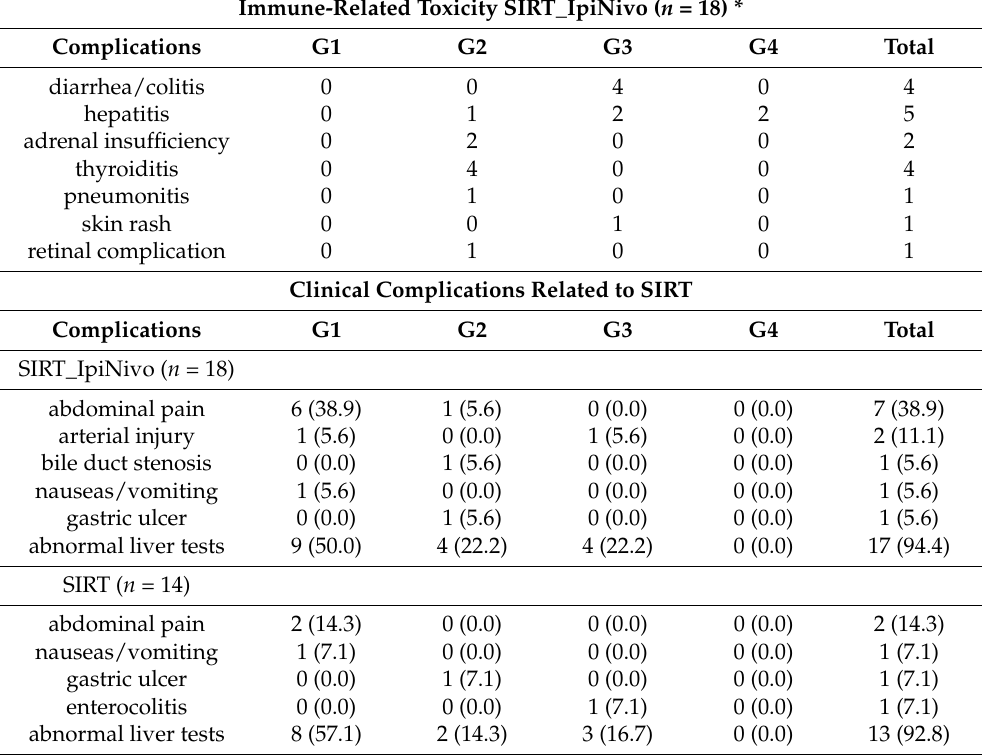
Table 3. Summary of